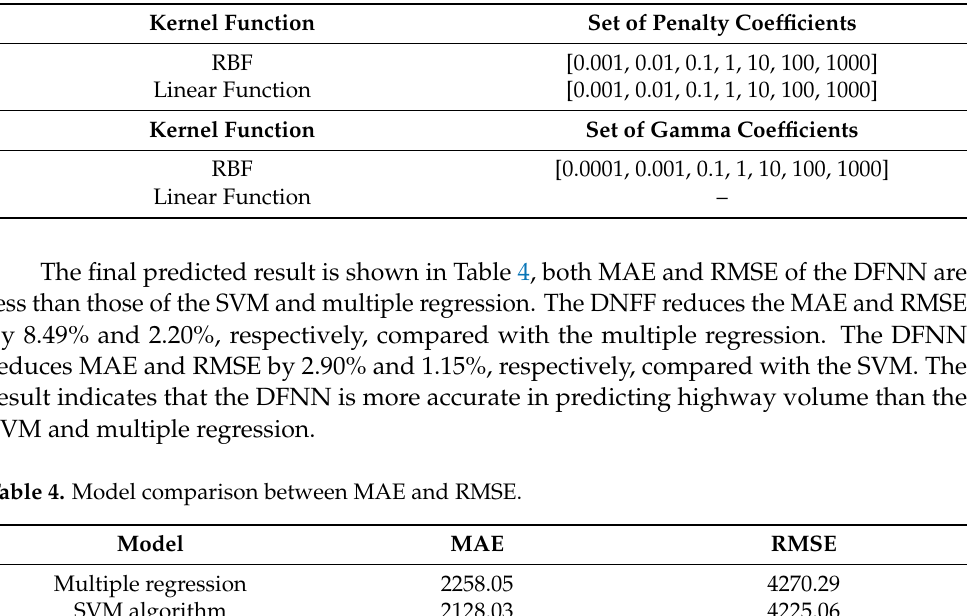
Table 3. The alternative sets of parameters in the SVM.